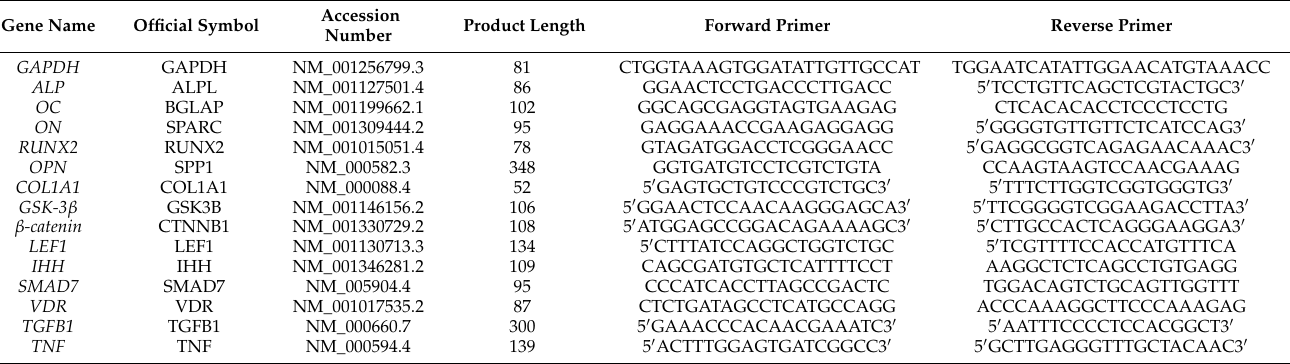
Table 1. List of SYBR Green primers used in this